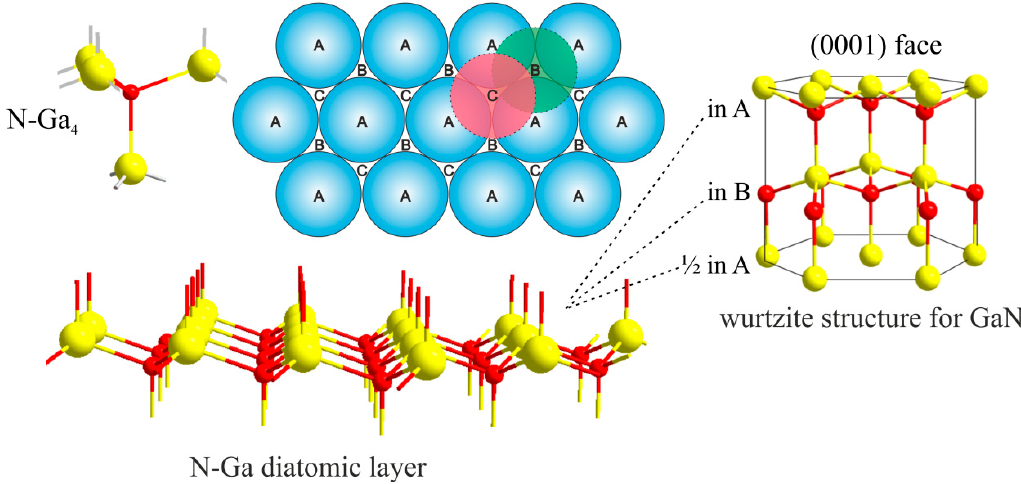
Figure 1. Structure of gallium nitride (GaN): particle of Ga 4 N in tetrahedral geometry, N-Ga diatomic hexagonal sheet, hexagonal close-packing (hcp) position model, and hcp structure with ABAB-type layering.